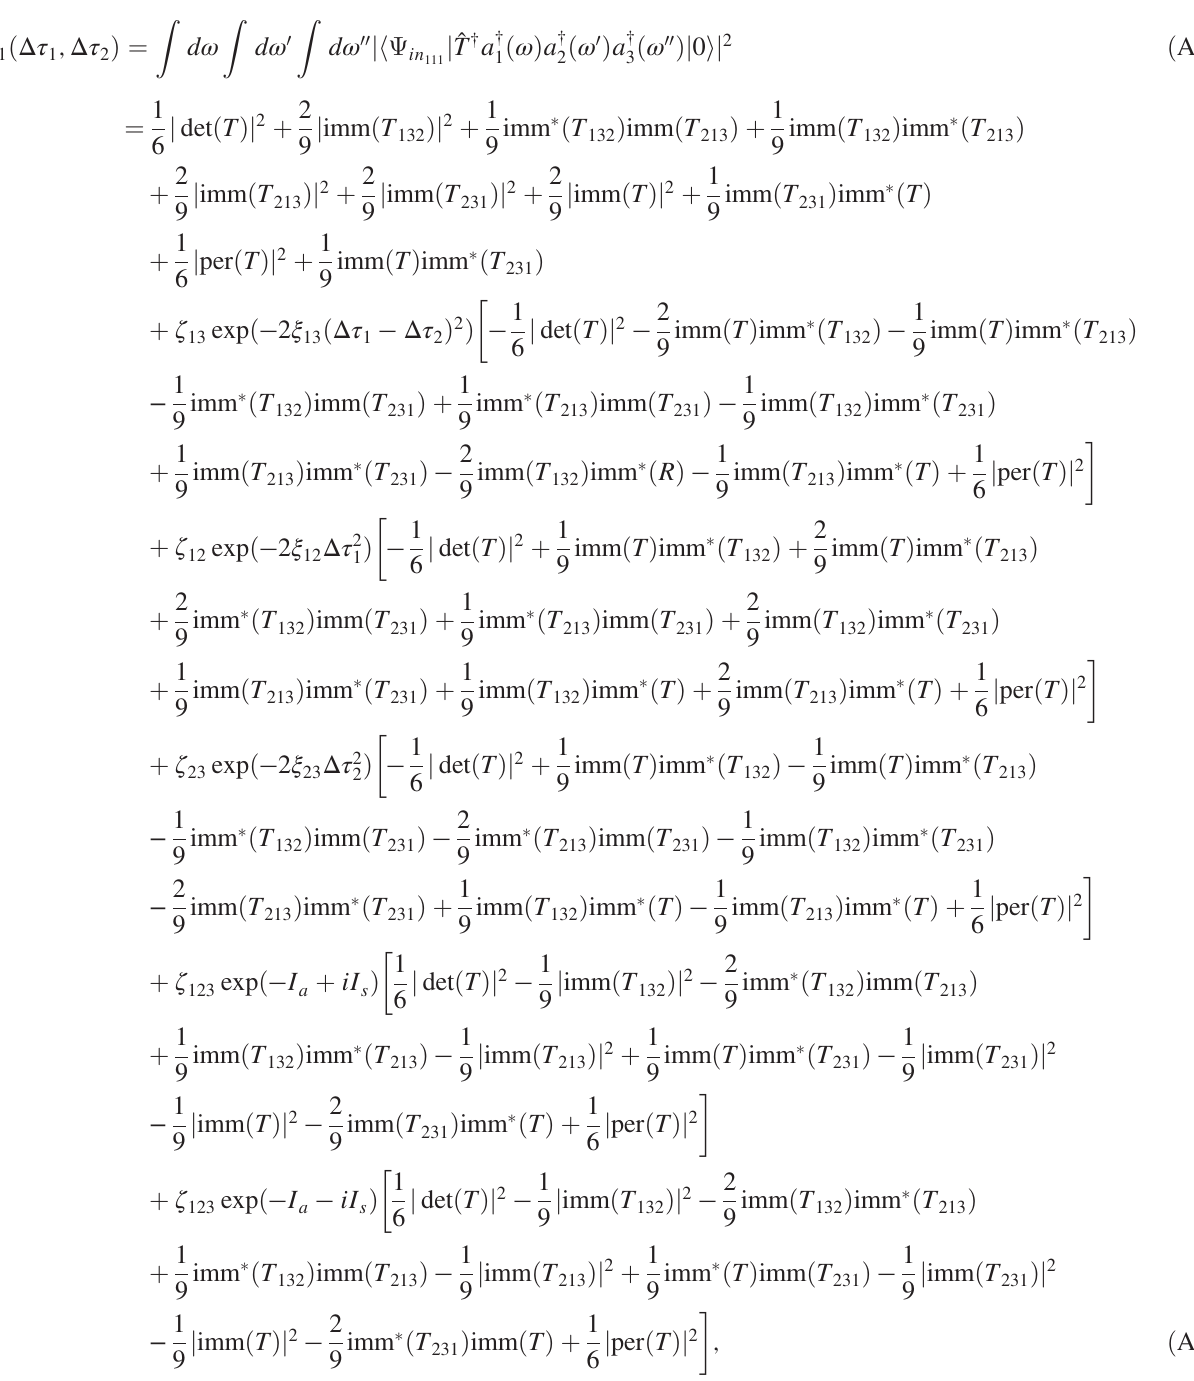
ffiffiffiffiffiffiffiffiffiffiffiffiffiffiffiffiffiffi ζ 12